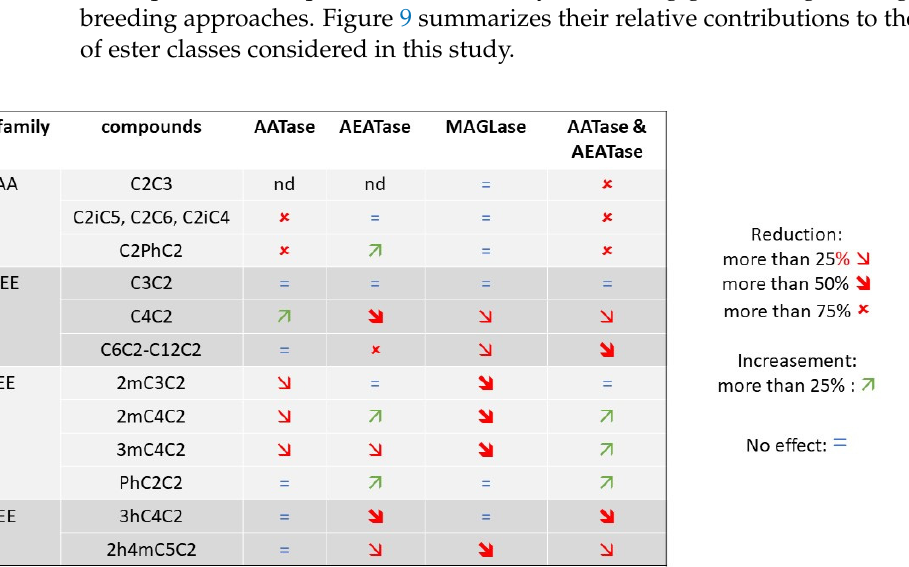
Figure 9. Relative contributions of AATses, AEATases, and MAGLases to the biosynthesis of volatile esters in a winemaking context.